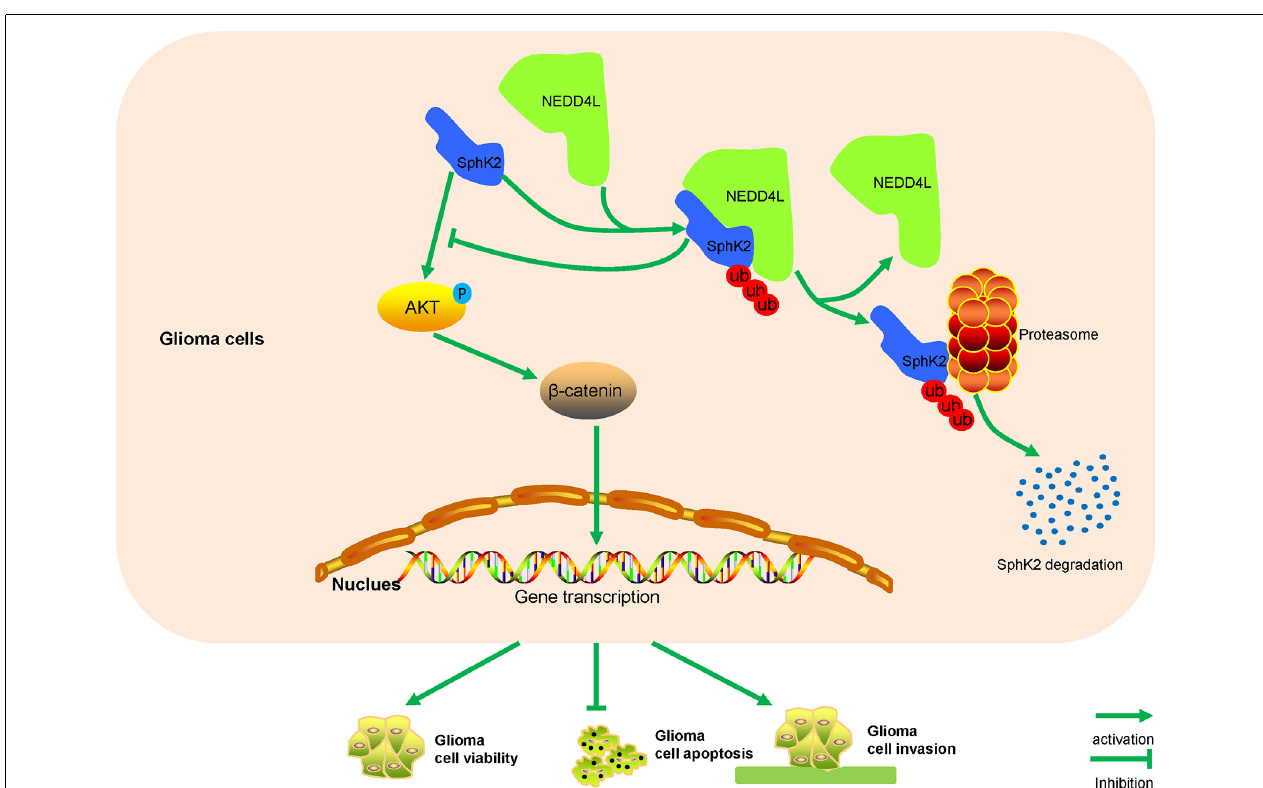
FIGURE 8 | A model for how NEDD4L-mediated SphK2 ubiquitination performs its roles in gliomas. NEDD4L targets SphK2 protein for degradation in the ubiquitin-proteasomal pathway, thus inhibiting the AKT/ β -catenin pathway to regulate glioma proliferation, apoptosis, and